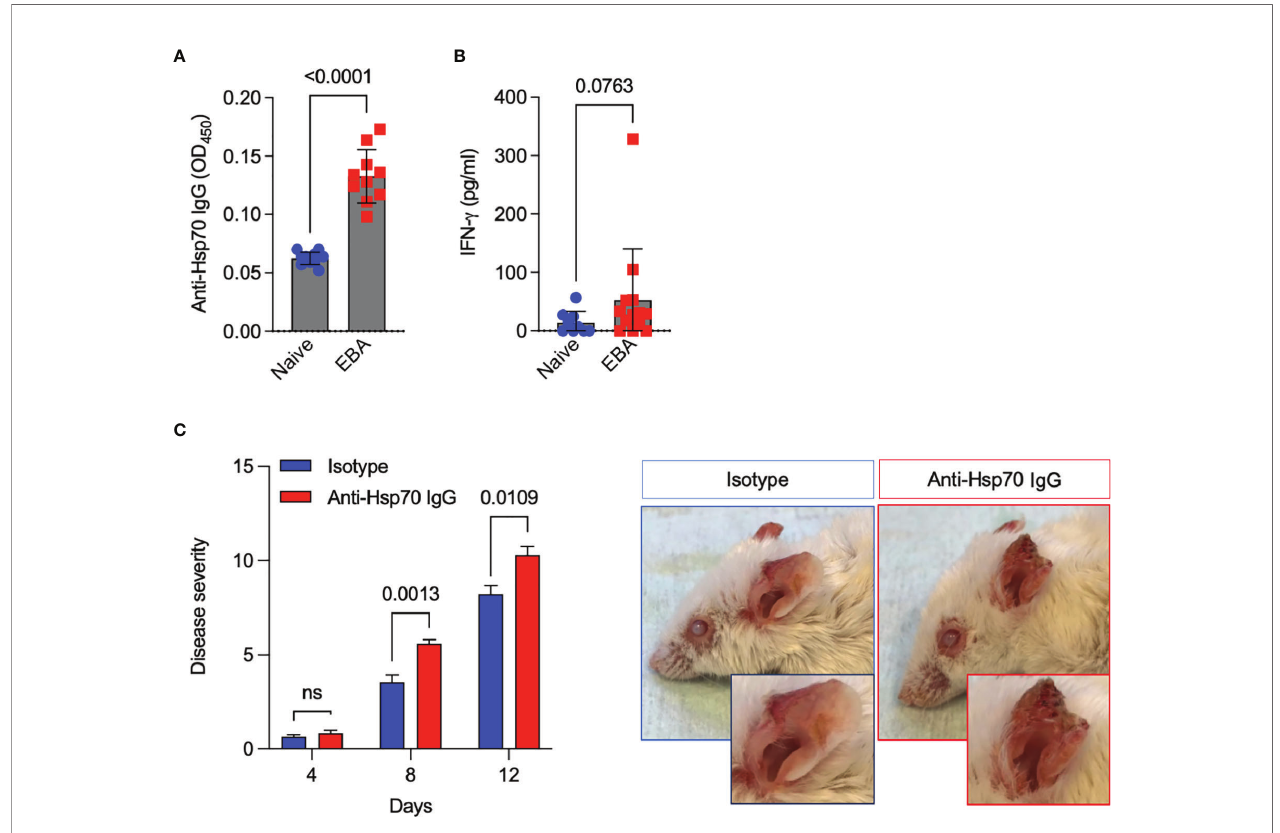
FIGURE 2 | Anti-Hsp70 antibody treatment aggravates experimental EBA. (A) Blood levels of anti-Hsp70 IgG and (B) IFN- g in naïve mice and mice with induced EBA were measured by ELISA at day 12. The results are expressed as mean values ± SEM of 9-13 mice per group. (C) Naïve BALB/c mice were injected intraperitoneally with mouse anti-Hsp70 IgG or IgG isotype control one day before the initial anti-COL7 IgG injection. Clinical scores were calculated as the percentage of the body surface area covered by EBA lesions. Representative clinical pictures of isotype control- and anti-Hsp70 IgG-treated mice at the end of the observation period (day 12) are shown on the right. The results are expressed as mean values ± SEM of 5 mice per group ns, not signi fi